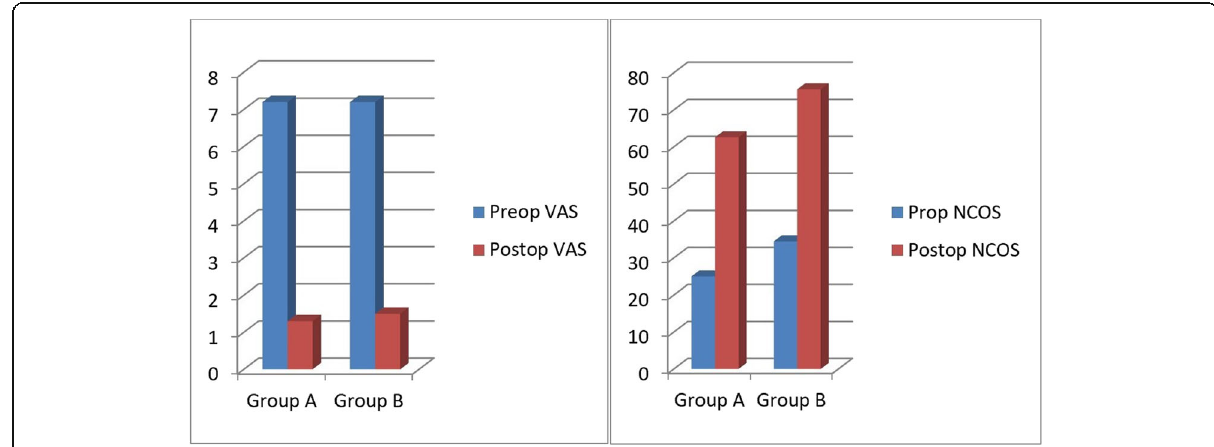
Fig. 2 Summary of pre- and postoperative mean VAS and